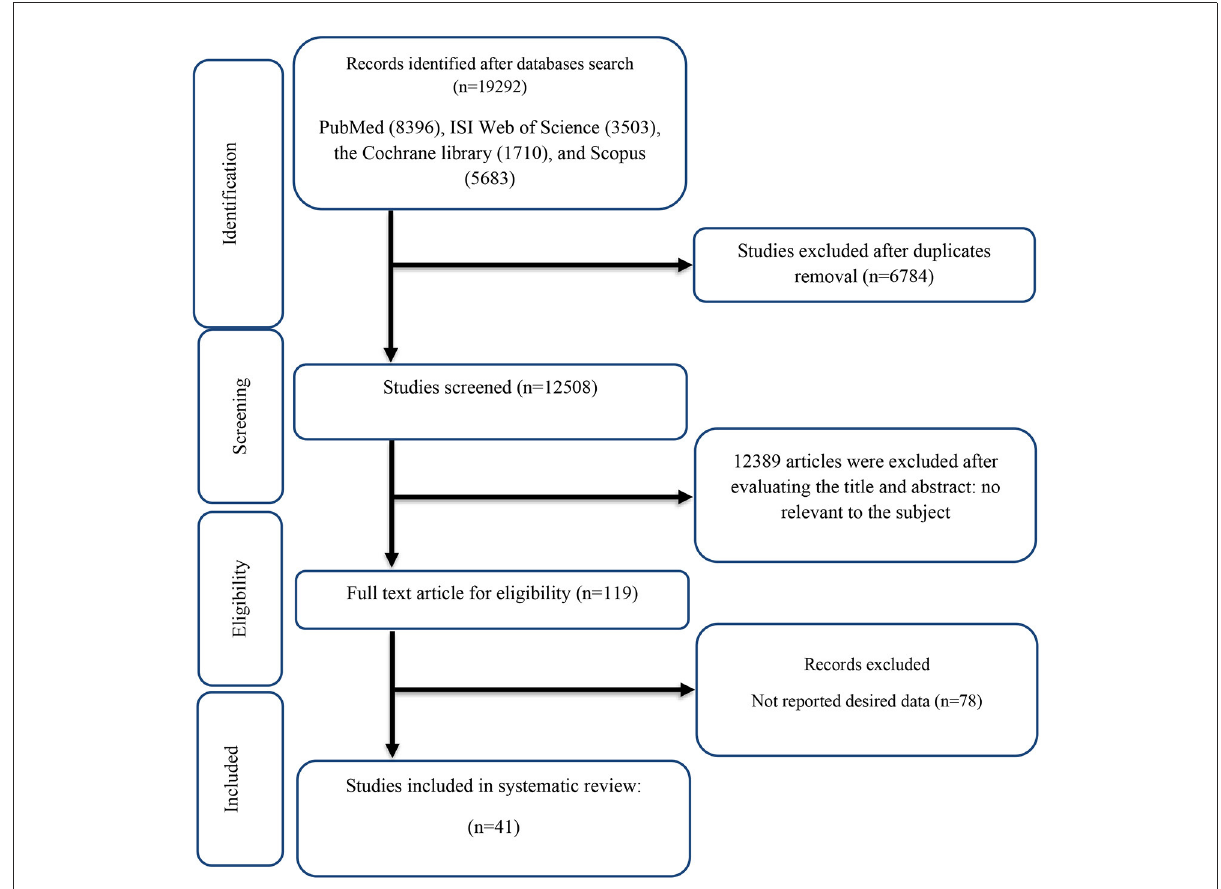
FIGURE1 Flow chart of study selection for inclusion trials in the systematic